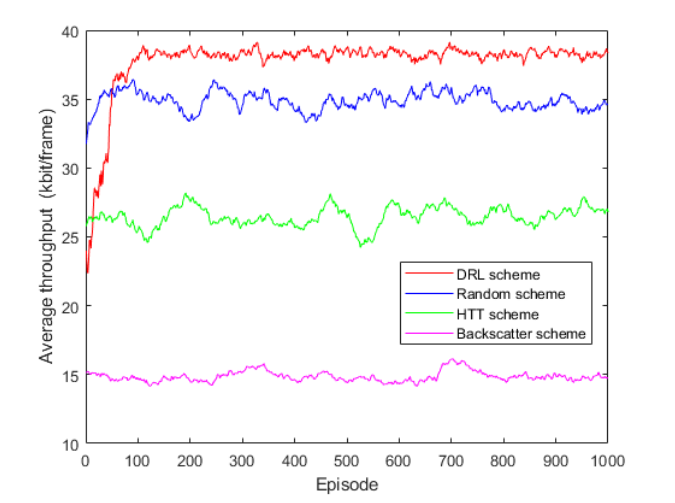
Figure 2. Convergence comparison between proposed DRL scheme and the baseline schemes in small-scale scenarios.